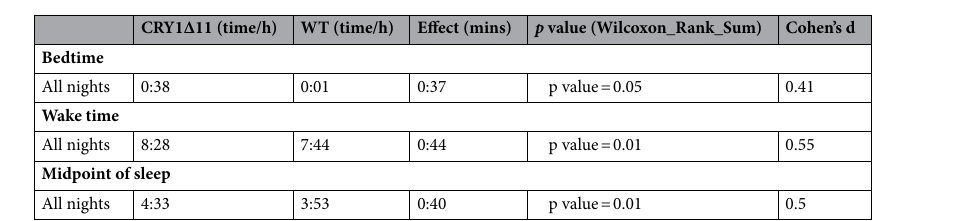
Figure 1. A. CRY1 lollipop plot showing the variant of interest, rs184039278, with respect to the domains and location of other known coding variants.